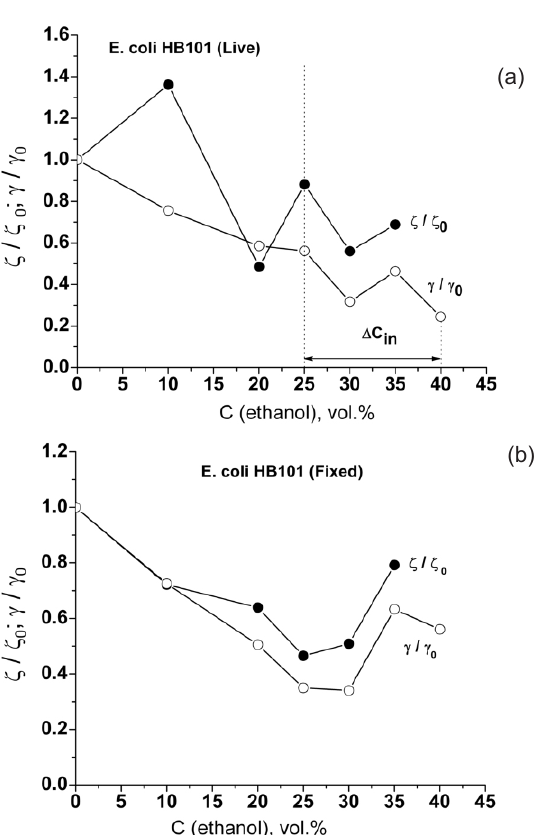
Figure 9. (a) The dependence of the zeta-potential ( z ) of live E. coli HB101 on the concentration of ethanol. (b) The dependence of the zeta-potential ( z ) of fixed E. coli HB101 on the concentration of ethanol.